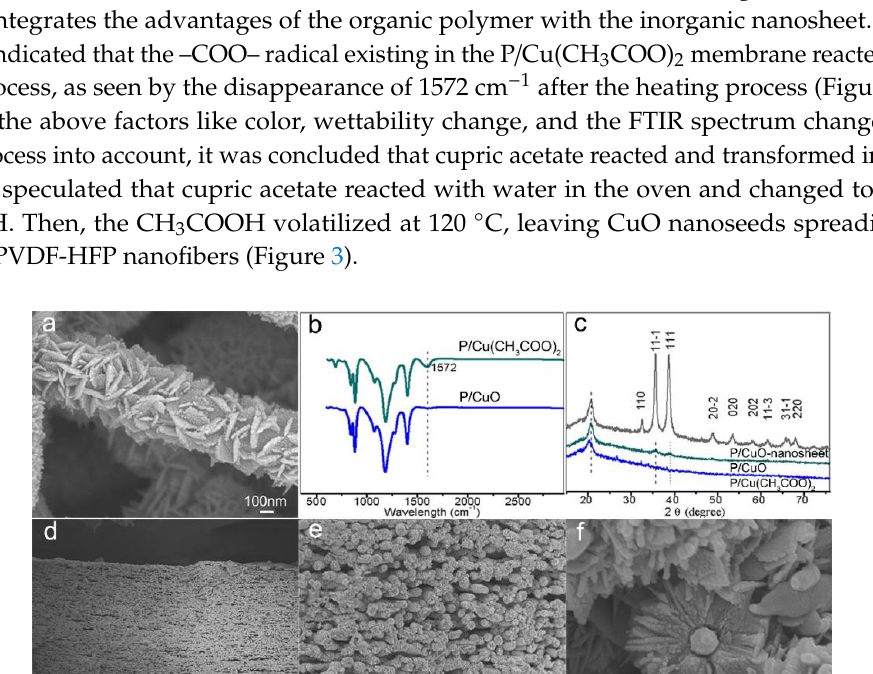
Figure 3. Morphology and structure of core – shell P/CuO-nanosheet membrane: ( a ) the morphology amplified by FE-SEM; ( b ) the FTIR spectrum of P/Cu(CH 3 COO) 2 and P/CuO membrane; ( c ) the XRD spectrum of P/Cu(CH 3 COO) 2 , P/CuO, and P/CuO-nanosheet membranes; ( d – f ), the cross-section morphology with different magnification ( d ) ×700, ( e ) ×5000, and ( f ) ×60,000.